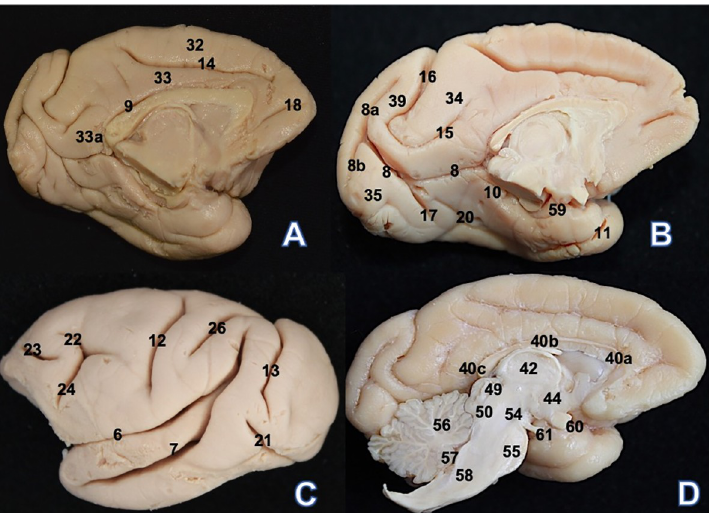
Fig 3. Sapajus libidinosus (SP1) encephalon. (A) Medial view: 9. Sulcus of the corpus callosum 14. Cingulate sulcus 18. Rostral sulcus 32. Medial frontal gyrus 33. Cingulate gyrus 33a. Cingulate gyrus isthmus. (B) Medial view: 8. Calcarine sulcus 8a. Superior ramus 8b. Inferior ramus 10. Hippocampal sulcus 11. Rhinal sulcus 15. Subparietal sulcus 16. Parieto-occipital sulcus 17. Collateral sulcus 20. Occipital-temporal sulcus 35. Occipital gyrus 59. Uncus 39. Cuneus. (C) Lateral view: 6. Lateral sulcus 7. Superior temporal sulcus 12. Central sulcus 13. Lunatus sulcus 21. Inferior occipital sulcus 22. Longitudinal superior sulcus 23. Longitudinal inferior sulcus 24. Vertical sulcus 26. Postcentral sulcus. (D) Medial view: 40a. Corpus callosum genu 40b. Corpus callosum trunk 40c. Corpus callosum splenium 42. Thalamus 44. Hypothalamus 49. Superior colliculus 50. Inferior colliculus 54. Mesencephalon 55. Pons 56.